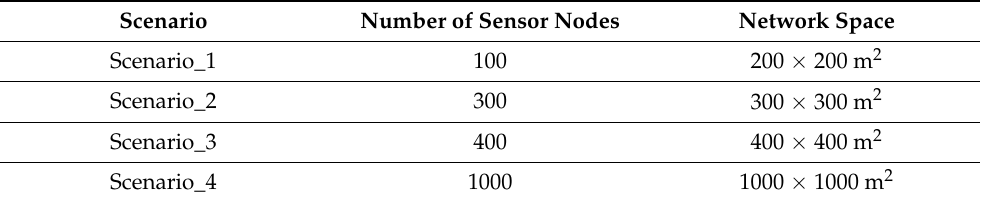
Table 3. Scenarios for the proposed protocol.